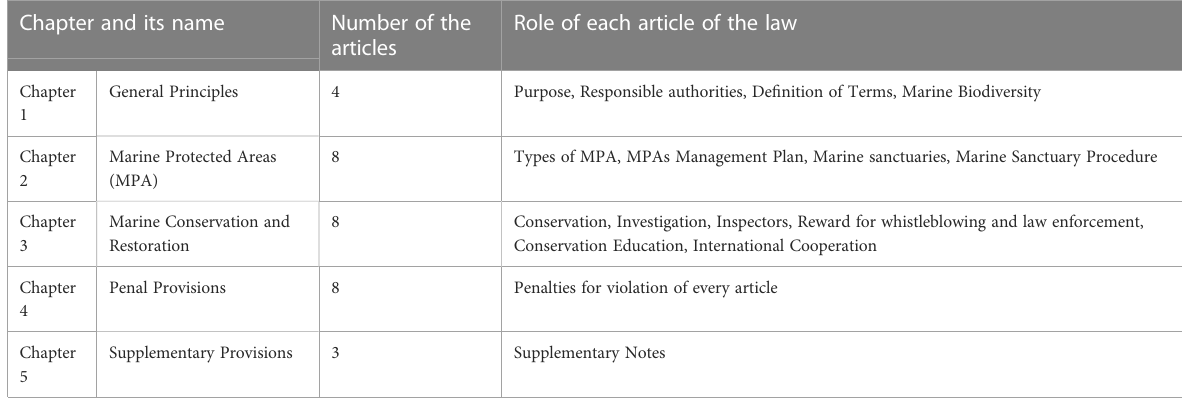
TABLE 3 The Legal system of the draft of the Marine Conservation